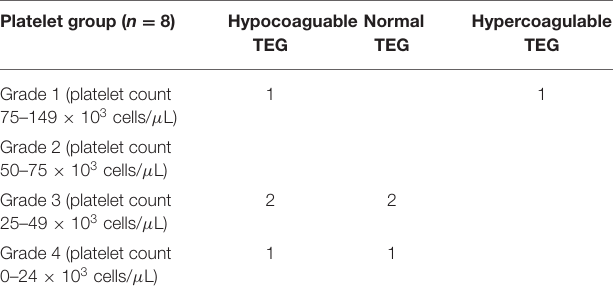
TABLE 4 | Thromboelastography (TEG) interpretation, by platelet group. Platelet group ( n = 8)